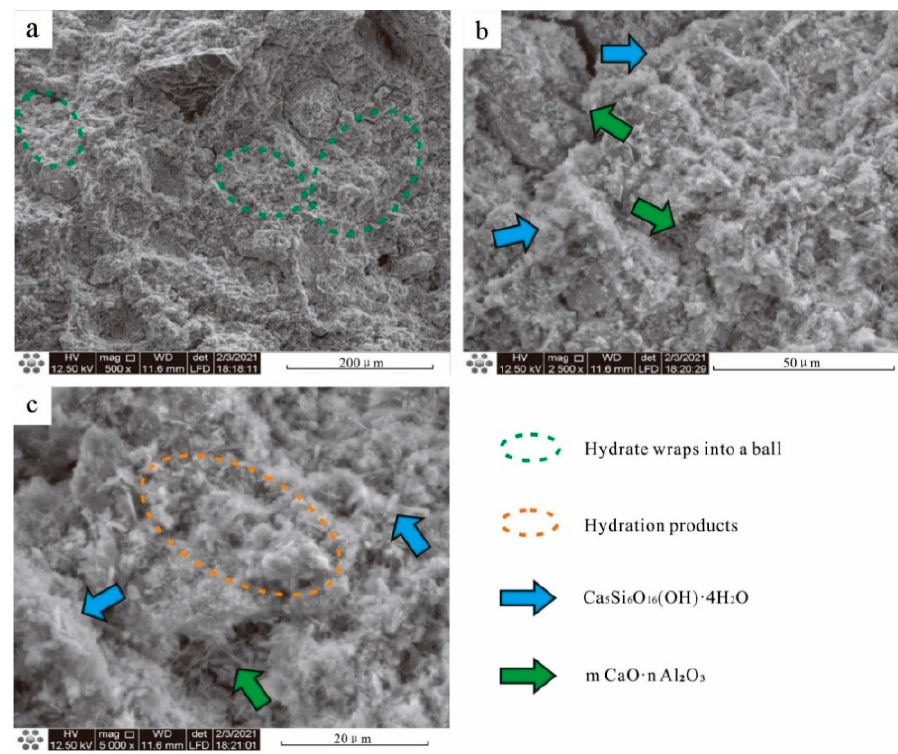
Figure 17. Microstructure of RCSLP solidified soil.